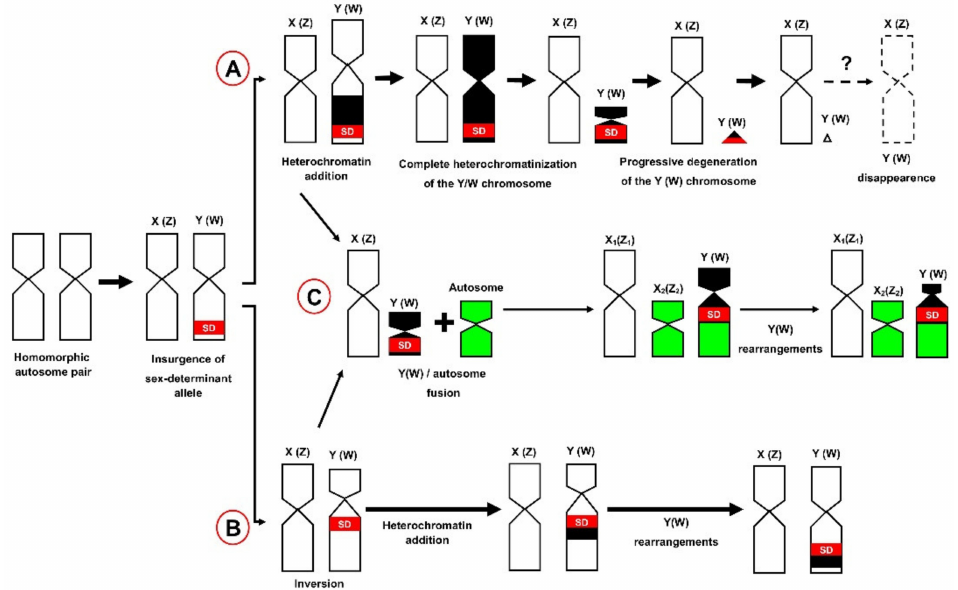
Figure 1. Pathways of sex chromosome diversification in lizards: ( A ) diversification by progressive heterochromatinization, ( B ) diversification by chromosome inversion and ( C ) formation of multiple sex chromosome systems by sex chromosome– autosome